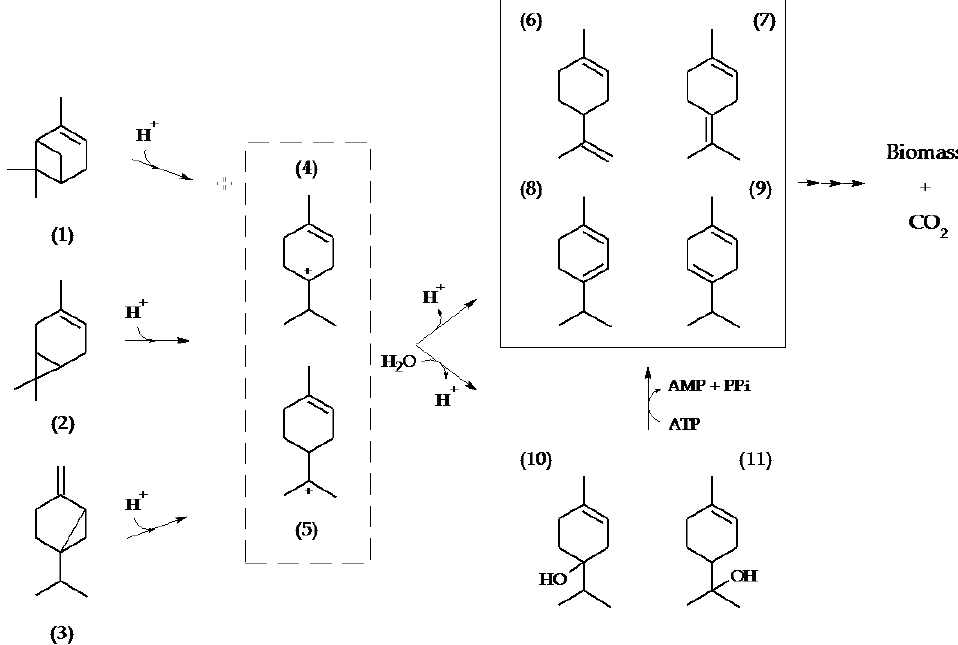
Figure 3. Proposed pathway for the degradation of the bicyclic monoterpenes α -pinene (1), 3-carene (2) and sabinene (3) in C. defragrans 65Phen. Electrophilic attack on the allylic double bond and an intramolecular rearrangement generates the monocyclic transient carbocations terpinen-4-yl (4) and α -terpinyl (5). These can deprotonate into monocyclic monoterpene olefins such as (6), (7), (8), (9) or hydroxylated to (10) and (11) by water addition. The alcohols may be dehydrated via an ATP-dependent reaction to monoterpene olefins.